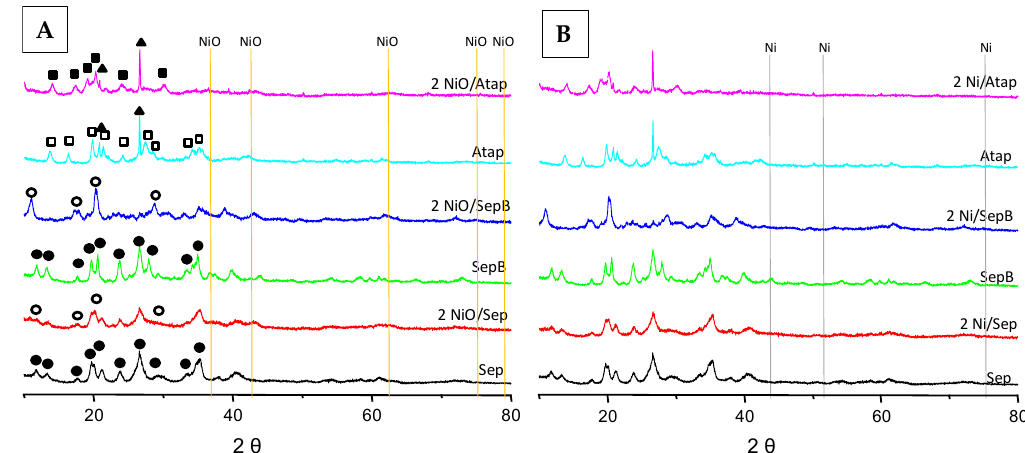
Figure 1. XRD patterns of NiO precursors ( A ) and final Ni catalysts ( B ) and the supports (Sep, SepB and Atap). Symbols: ( ● ) sepiolite, (o) sepiolite-dehydrated, ( □ ) a tt apulgite, ( ▪ ) attapulgite-dehydrated, ( ▲ ) quartz. – NiO, -- Ni.